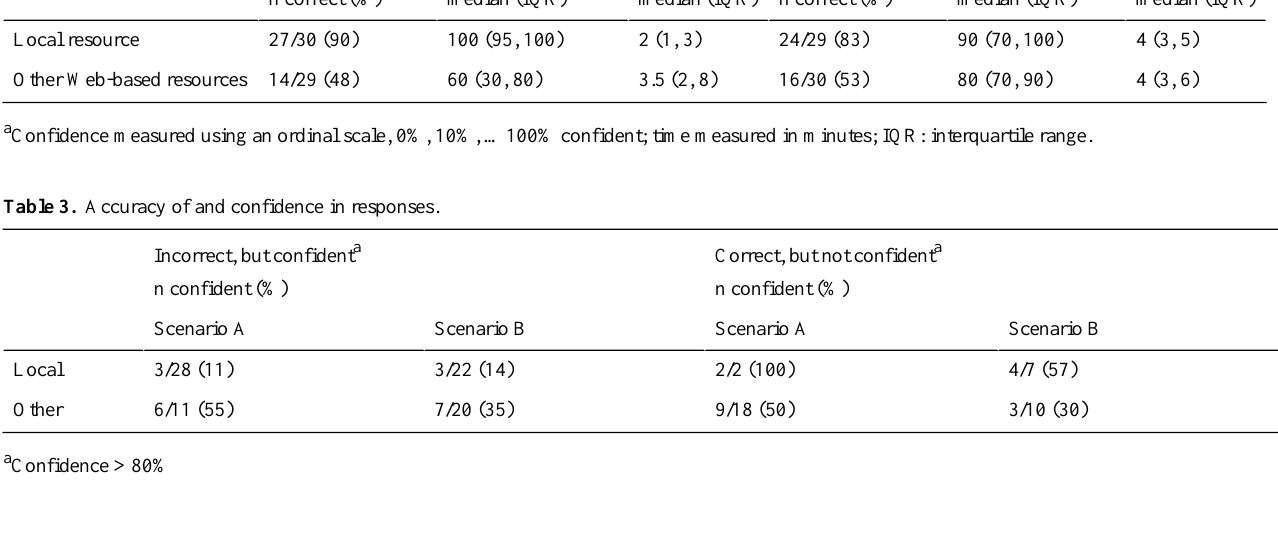
a Between-groups comparison across all training levels: P =.38. Staff MD: staff physician; PA/NP: physician's assistant/nurse practitioner; PG: postgraduate